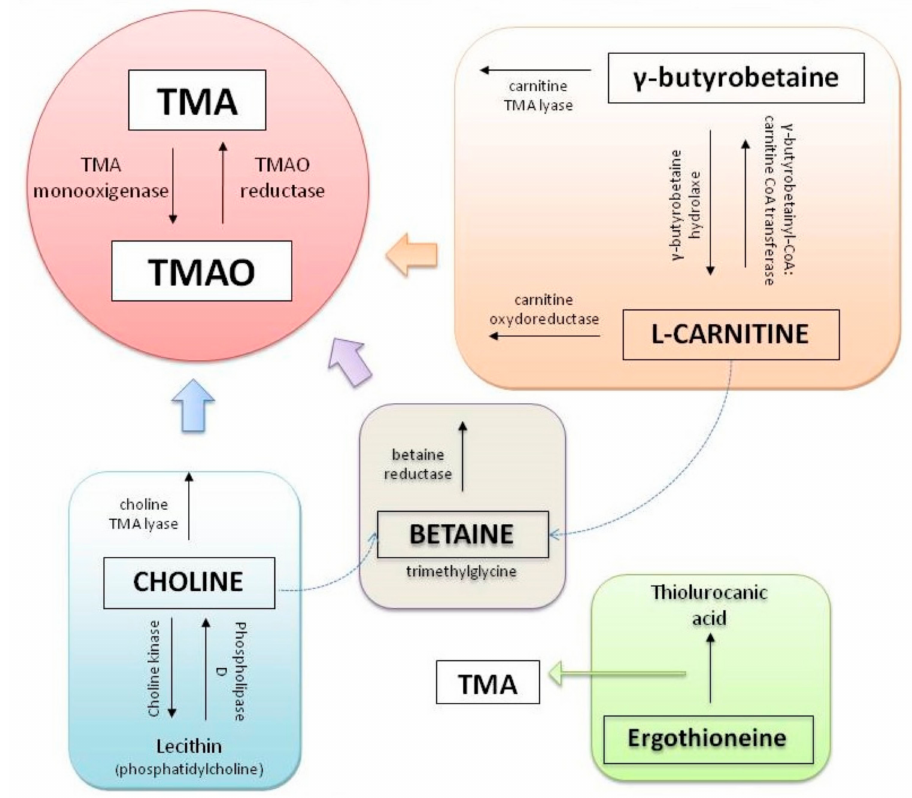
Figure 3. Principal pathways to formation of trimethylamine (TMA) and trimethylamine N-oxide reductase (TMAO). There is a recognized association between TMAO and inflammation [48–52]. Indeed, TMAO triggers vascular inflammation by activation of caspase 1, producing and secreting pro-inflammatory cytokines (IL-1 β and IL-18) and activating the NACHT, LRR, and PYD domains-containing protein 3 (NLRP3) inflammasome [53]. Activation of inflammasome has been linked to heart failure, adverse heart remodeling, and cytokine-mediated systolic dysfunction. The effects of TMAO on the components of the intrinsic cardiac